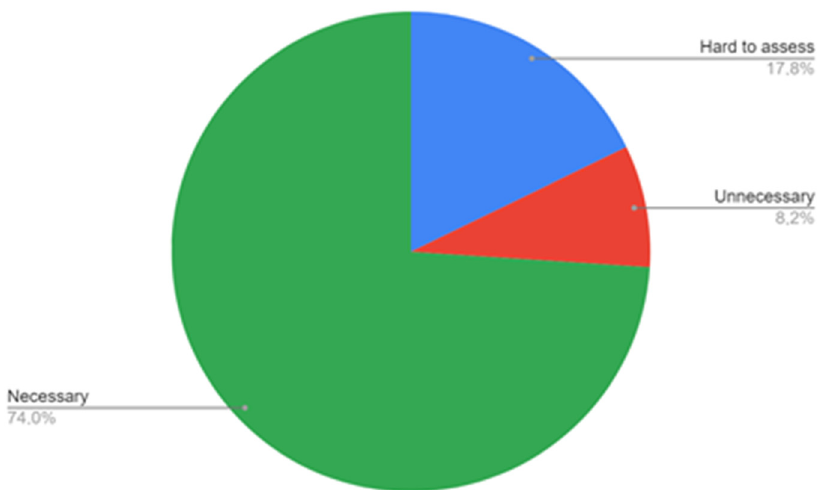
Figure 3. Respondents’ opinion on the necessity of ABI measurements in primary care.